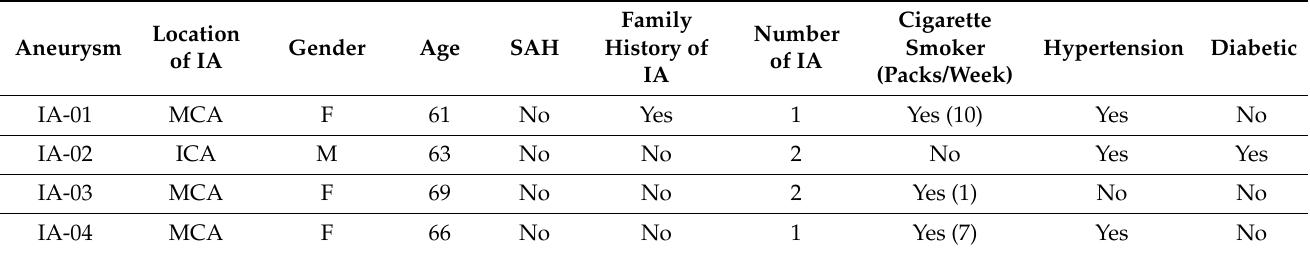
Table 1. Clinical data summary for four unruptured intracranial aneurysm cases (MCA = middle cerebral artery, ICA= internal cerebral artery)